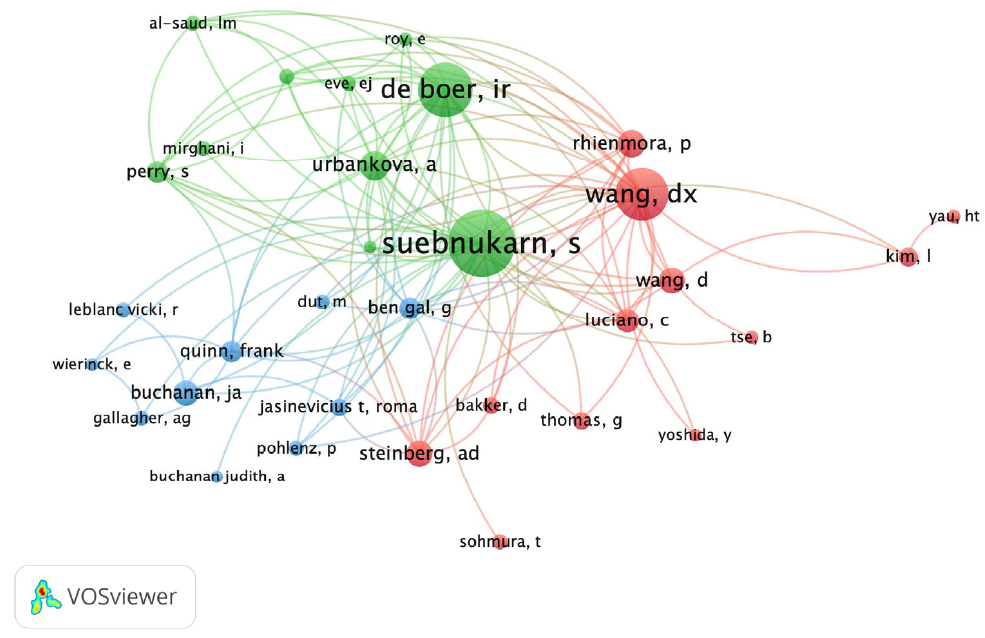
Figure 2. The author co ‐ citation network that contributed with minimum ten times of citations of an author.